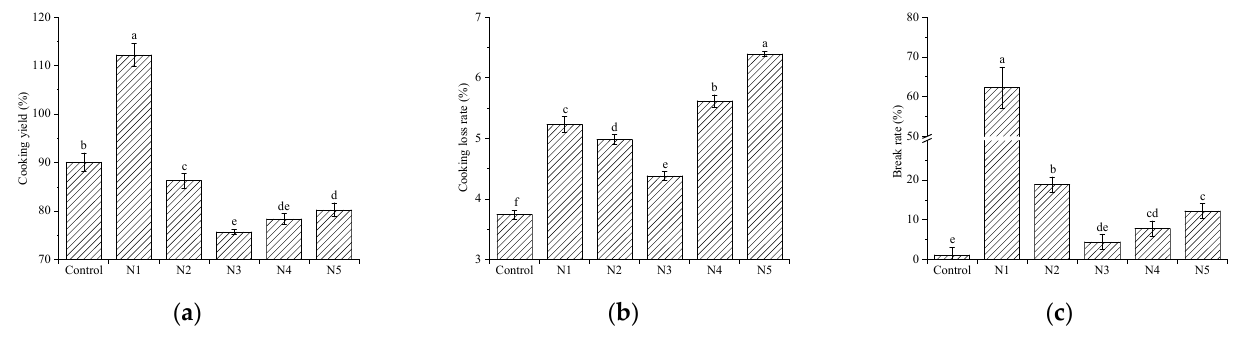
Figure 2. Cooking properties of whole-wheat noodles. ( a ) Cooking yield; ( b ) cooking loss rate; ( c ) breaking rate. Different lowercase letters on columns indicate significantly different values ( p < 0.05). N1, N2, N3, N4, and N5 are noodles corresponding to wheat bran with decrease in particle size sequentially. The noodles made from refined wheat flour served as a control group.